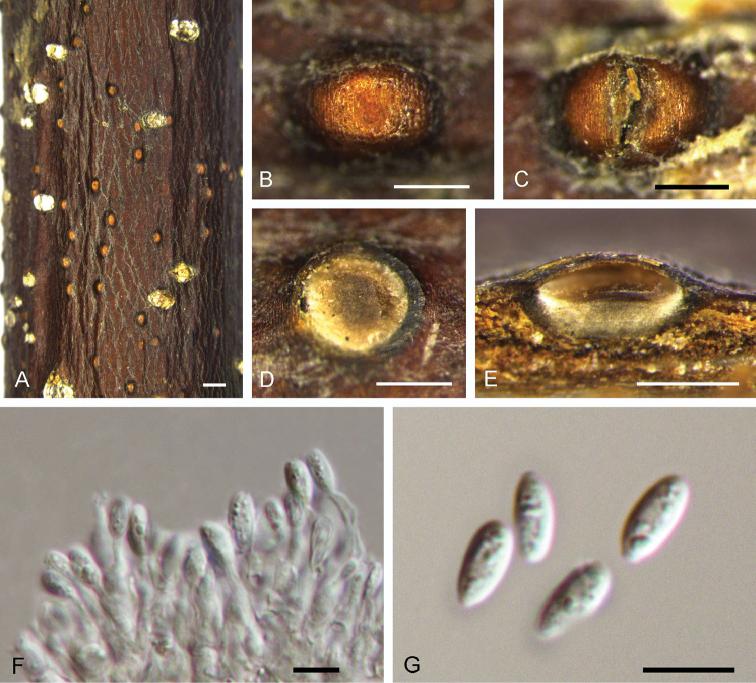
Morphology of Dendrostomashandongense from Castaneamollissima (BJFC-S1567). A–C Habit of conidiomata on branches D Transverse section of conidioma E Longitudinal section through conidioma F Conidiogenous cells G Conidia. Scale bars: 1 mm (A); 0.3 mm (B–D); 5 μm (F); 5 μm (G).